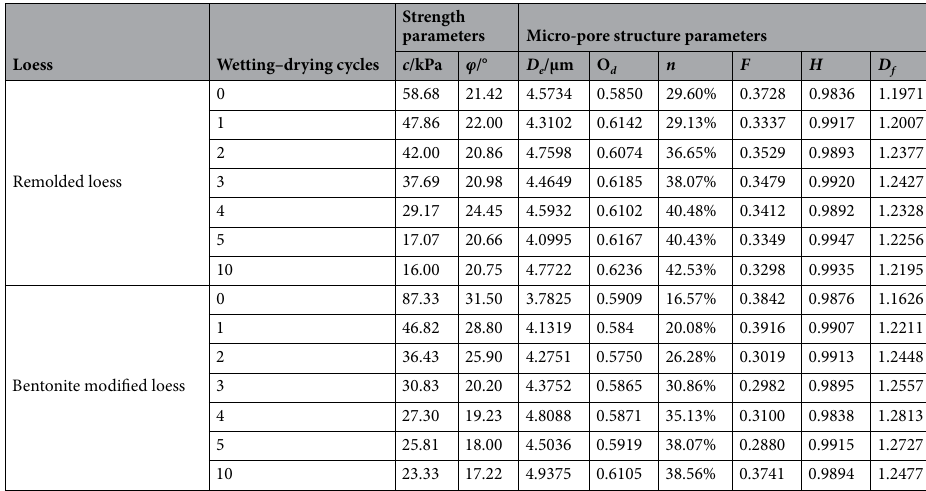
Table 3. Summary of strength and micro-pore structure parameters of loess.